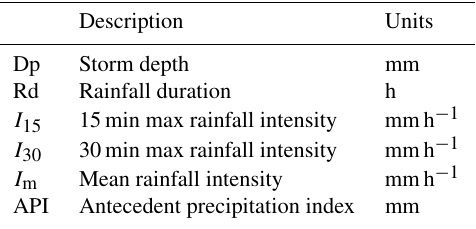
Table 1. Precipitation condition variables determined for each mon- itored runoff